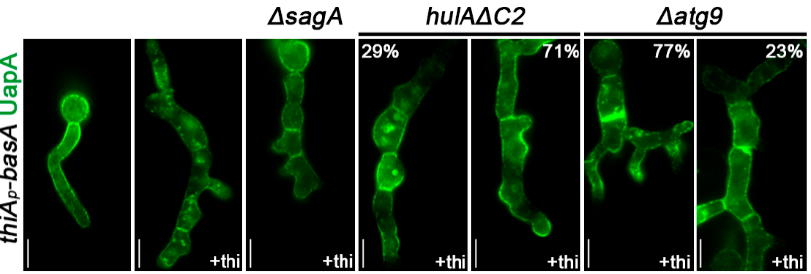
Figure 6. BasA-dependent localization of UapA in mutants blocked HECT-type endocytosis, ubiq- uitination or selective autophagy. The figure shows epifluorescence microscopy images of strains expressing de novo made UapA-GFP in ∆ sagA, hula ∆ C2 and ∆ atg9 genetic backgrounds. Details of conditions used are as those described in the legend of Figure 2C. Notice the full or partial protec- tion of UapA from endocytosis in ∆ sagA and hula ∆ C2 or ∆ atg9, respectively. Biological/technical replicates 2/120 for each strain. Unless stated otherwise, the images shown represent the outcome observed in 100% of cells examined. Scale bars: 5 μ m.